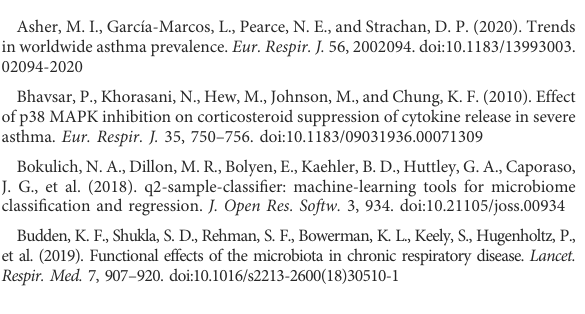
SUPPLEMENTARY FIGURE S1 Total ion chromatography (TIC) of the blank samples. TIC of the blank samples inpositiveion mode; (B) Total ion chromatography of the blank samples in negative ion mode. SUPPLEMENTARY FIGURE S2 The leukocyte cell type counts in BALF samples. The BALF was centrifuged and the precipitated cells were counted after staining by Wright-Giemsa. Data are expressed as the mean ± standard deviation (SD) and were performed with one-way ANOVA followed by Tukey ’ s tests. ( n = 6, △ p ≤ 0.05 vs. the OVA group, △△ p ≤ 0.01 vs. the OVA group; # p ≤ 0.05vs.thebudesonide(BUD)group, ## p ≤ 0.01vs.theBUDgroup; ◆ p ≤ 0.05 vs. the QFM group, ◆◆ p ≤ 0.01 vs the QFM group; ns: no difference; line over bars indicates that all groups are